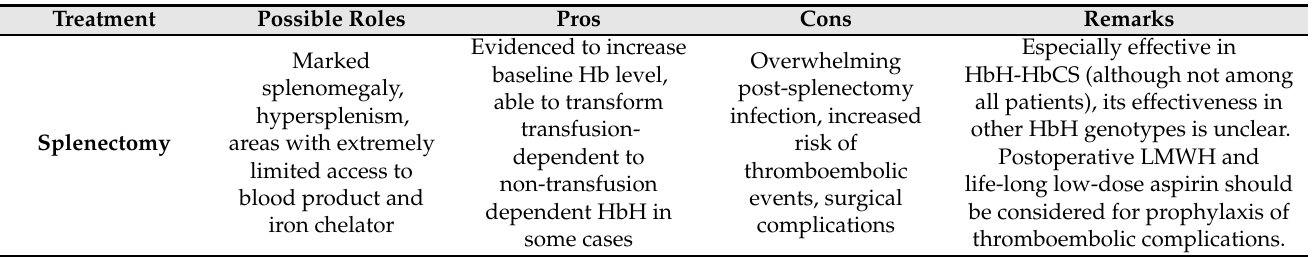
Table 3. Natural history-modifying treatments of